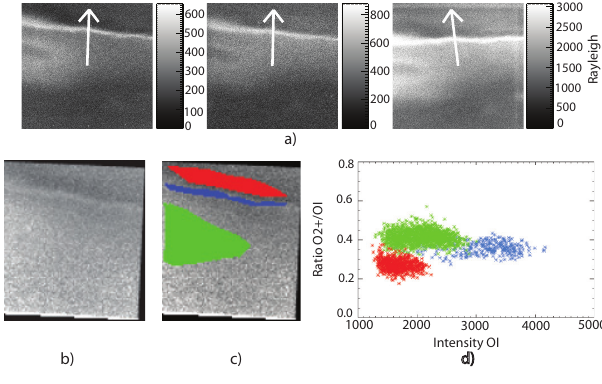
Fig. 9. (a) Images from ASK1 (O + ), ASK2 (O + ) and ASK3 (OI) 2 at 21:14:02,750 on 2 January 2006. The north direction in the im- Fig. 9. a) Images from ASK1 ( O + ), ASK2 ( O + ) and ASK3 ( OI ) at 2 ages is indicated with an arrow. (b) O + /OI ratio plot. (c) ratio 21:14:02,750 on 2 January 2006. The north direction in the images 2 plot marked with three regions with different characteristic intensi- is indicated with an arrow. b) O + / OI ratio plot. c) ratio plot marked 2 ties (d) plot of ratio against OI emission for each pixel in the three with three regions with different characteristic intensities d) plot of regions. It is clear that the three regions have different ratios. ratio against OI emission for each pixel in the three regions. It is clear that the three regions have different ratios.